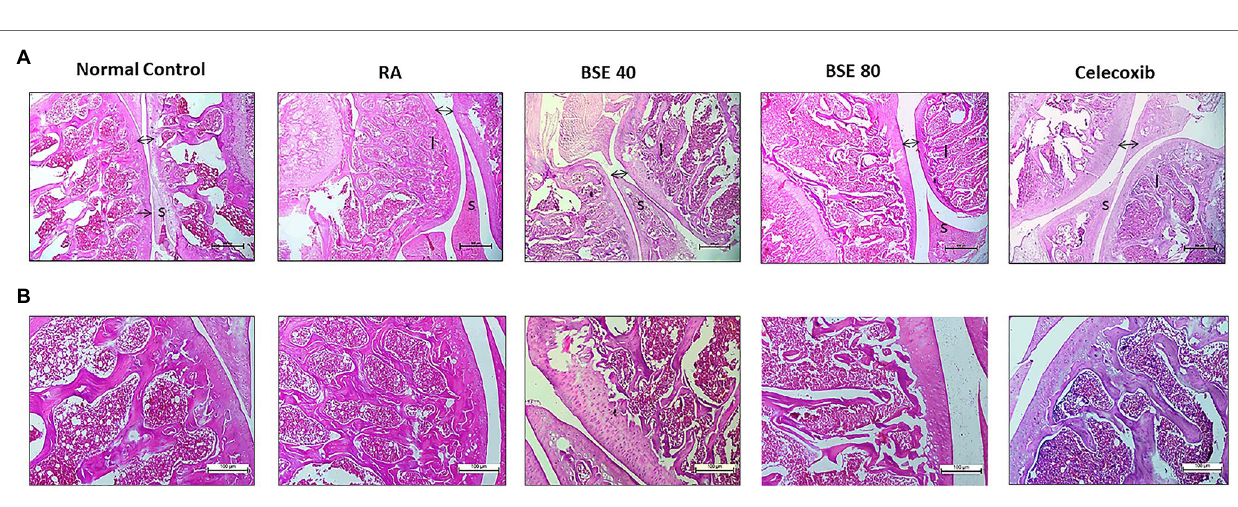
FIGURE 6 | (A) H- and E-stained histopathological images of a typical ankle joint of each group. A, 4X and (B) 10X resolution. S, synoviocytes and synovial hyperplasia in diseased control. A double arrow indicates space between cartilage bone of joints, and increased space between bone cartilage was found in diseased control; “I” indicates inflammation in the bone marrow. BSE 40 and BSE 80, Boswellin Super Extract 40 and 80 mg/kg; CXB, celecoxib 10 mg/kg; and RA, rheumatoid